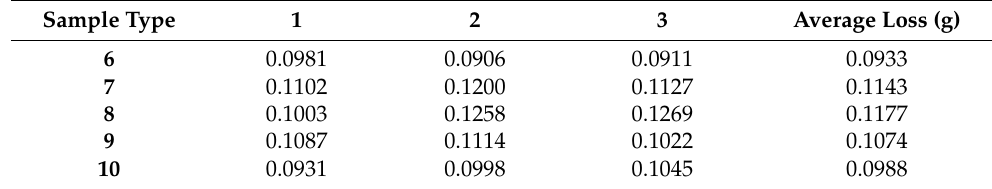
Table 8. Weight losses for Samples 6–10 (g).